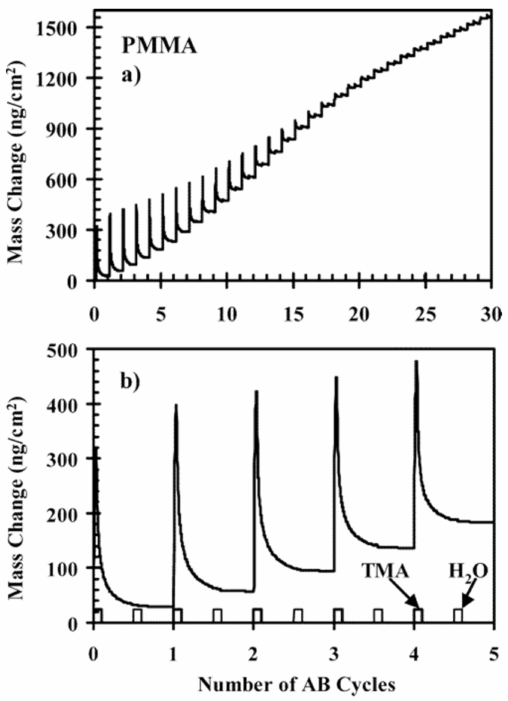
Figure 5. Mass change measurements by QCM versus number cycles of Al 2 O 3 ALD on PMMA at 85 ◦ C for ( a ) 30 and ( b ) 5 cycles (reprinted with permission from [40], Copyright (2005) American Chemical Society).